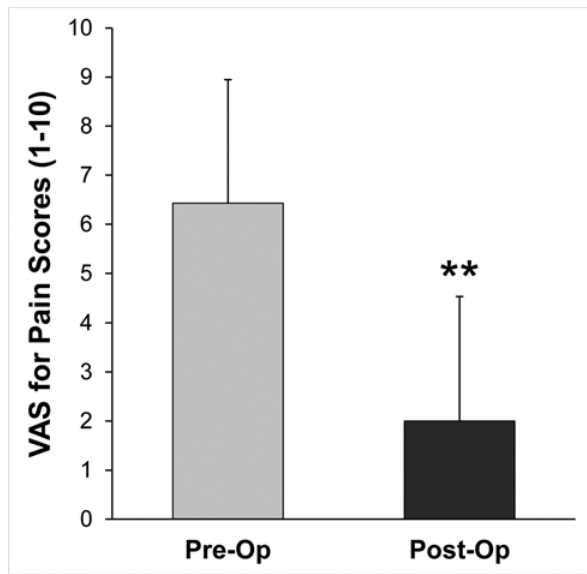
Fig. 7 Visual analogscale(VAS)forpainscoreswithinthebrachiumof the affected extremity, before and after surgery. Data shown as mean (cid:1) SD. ( n ¼ 21 patients). (cid:4) p < 0.05, (cid:4)(cid:4) p < 0.01. SD, standard deviation.